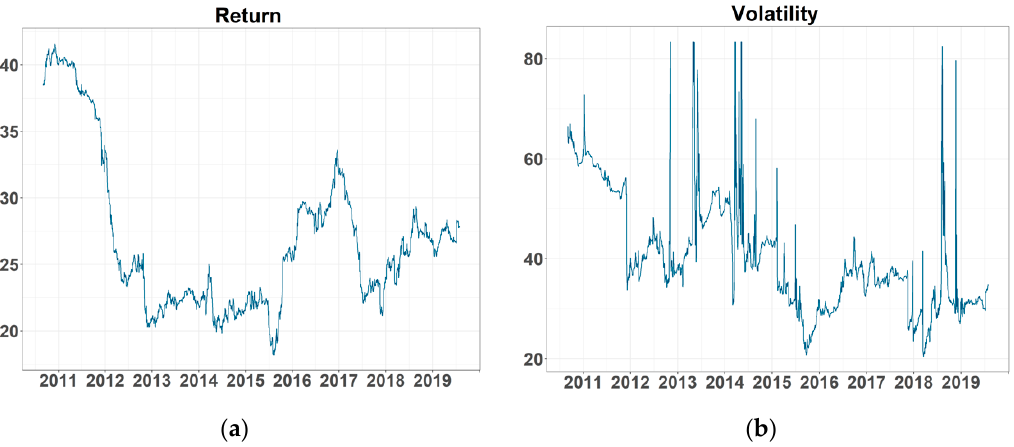
Figure 3. Dynamic connectedness: ( a ) total connectedness of return series and ( b ) total connectedness of volatilities. BRL, RUB, INR, CNH, and ZAR are Brazilian Real, Russian Ruble, Indian Rupee, offshore Chinese Yuan, and South African Rand, respectively.